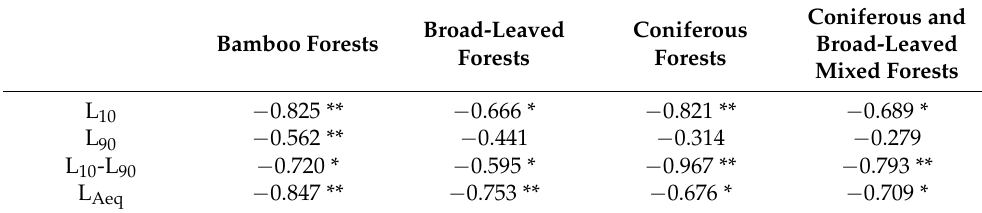
Table 1. Relationship between acoustic parameters and perceived pleasantness in different forest structures, where Pearson correlation coefficients are shown in each cell.